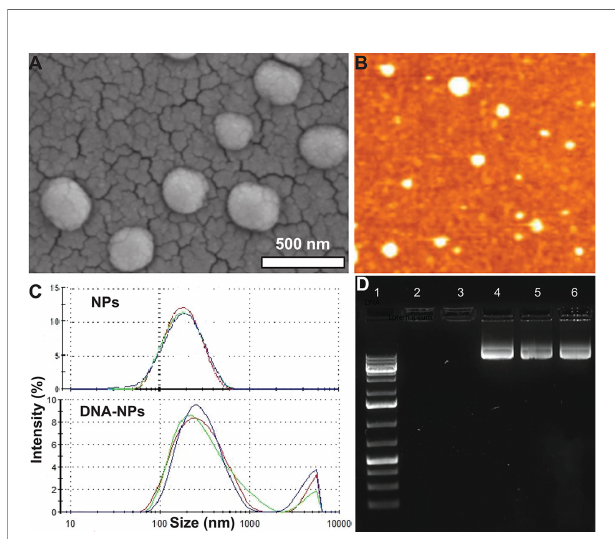
FIGURE 1 | Characterization of IL-4pDNA-NPs. (A) SEM and (B) AFM images show that NPs are spherically shaped, smooth and are monodispersed. (C) Size distribution of unloaded NPs (NPs) and human IL-4pDNA loaded NPs (IL-4pDNA- NPs). (D) Encapsulation of IL-4pDNA by NPs at various N/P ratios was detected by Agarose gel electrophoresis. Lane 1 is DNA ladder as size marker. Lanes 2 - 6 show IL-4pDNA-NPs at N/P ratios of 4, 2.6, 2, 1.8, and 1.6. No bands were detected at N/P ratios of 4 and 2.6, indicating full encapsulation. Unencapsulated IL-4pDNA bands were obtained from N/P ratios below 2, demonstrating overloading of pDNA into